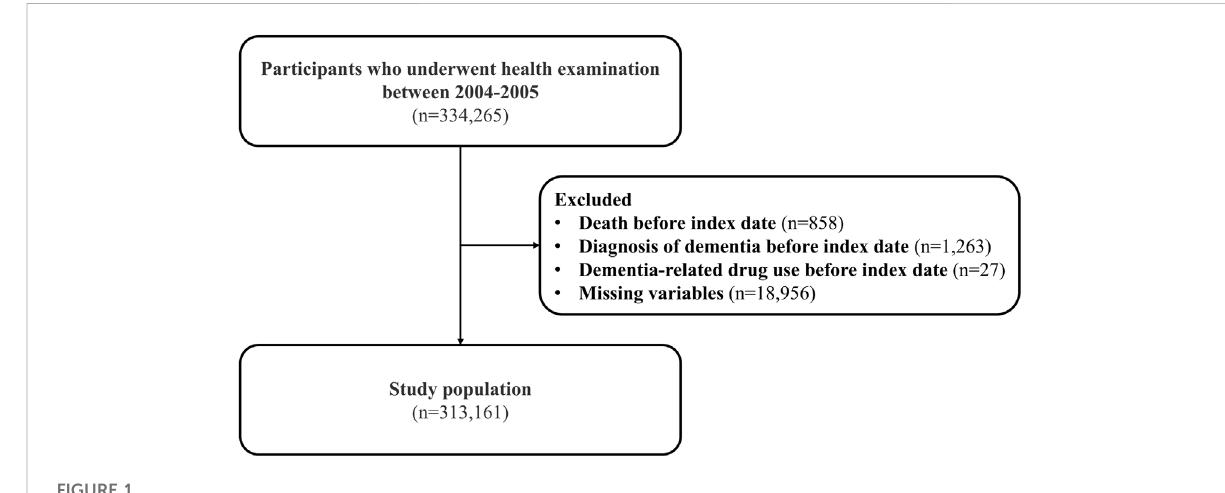
FIGURE 1 Study sample